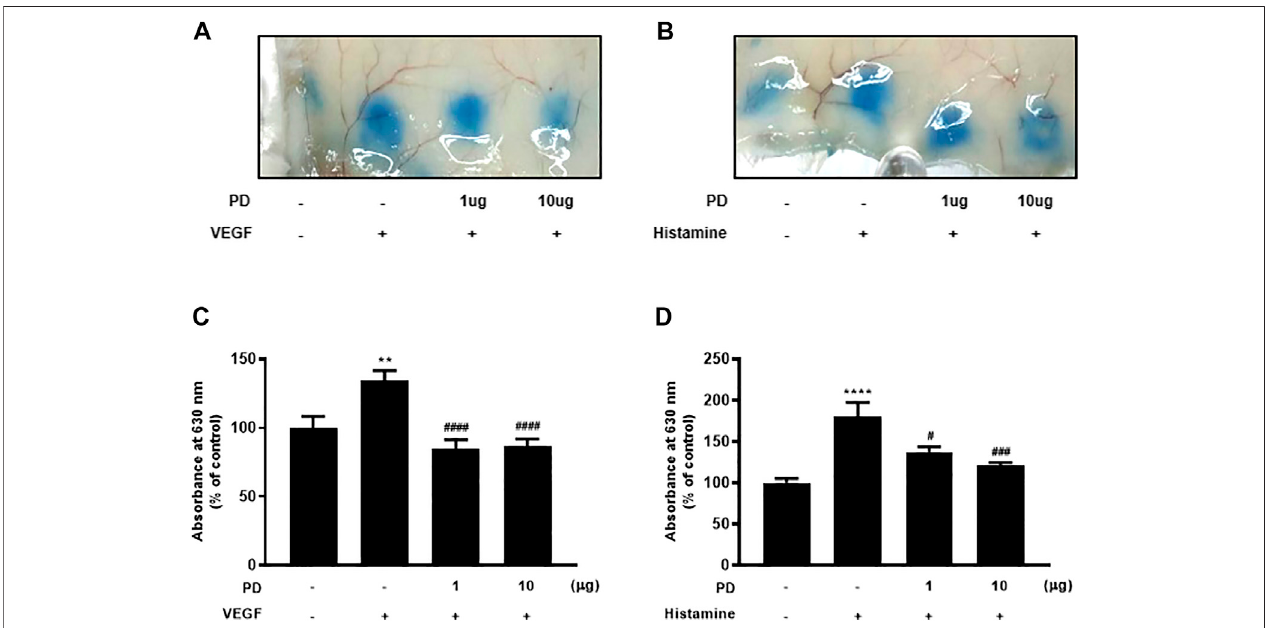
FIGURE2| PDtreatmentblocksVEGF-induced andhistamine-induced permeability invivo .Vascular permeability wasassessed using theMilesassay.Six-week- old mice were used, and mice were tail vein-injected with Evans blue dye followed by intradermal injection of VEGF (50 ng), histamine (500 nM), or PD (1 μ g or 10 μ g) (A,B) . The skin at the injection site was collected and photographed. (C,D) Evans blue dye was extracted from the skin by incubation with formamideat 56 ° C overnight, and the absorbance of the extracted dye was measured at 620 nm with a spectrophotometer ( n (cid:2) 7). All data are presented as means ± SEM, * p < 0.005, **** p < 0.0001 vs control group; # p < 0.05, ### p < 0.0005, #### p < 0.0001 vs inducer treated